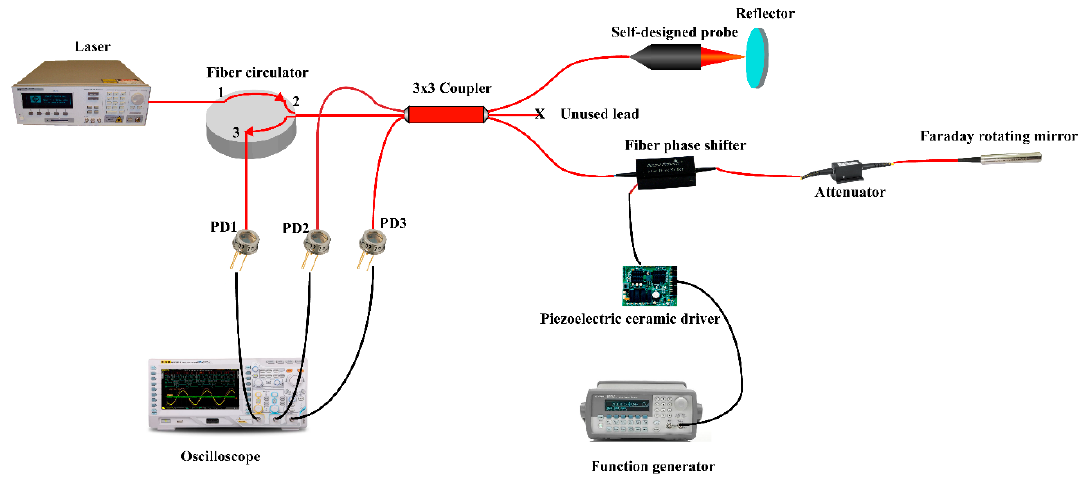
Figure 1. Schematic of the depolarization fading system based on a probe with a built-in Faraday